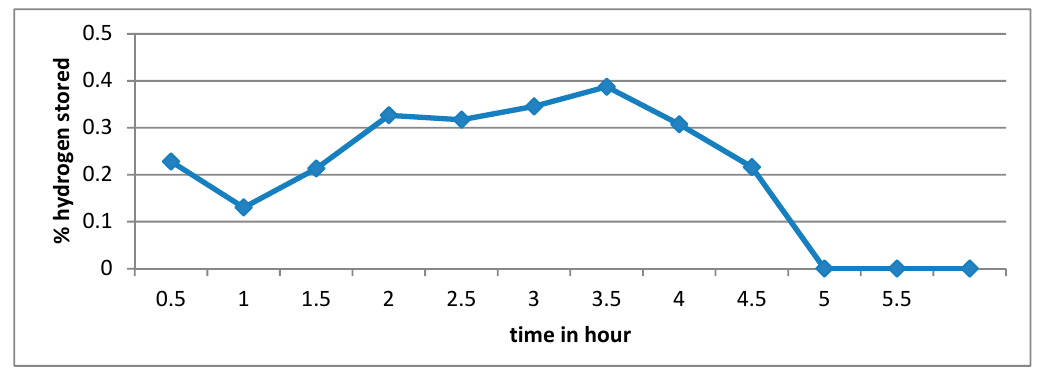
Figure 17. Graph showing the relation between wt% of hydrogen stored in carbon and time during charging of modified unitized regenerative fuel cell (URFC) or proton